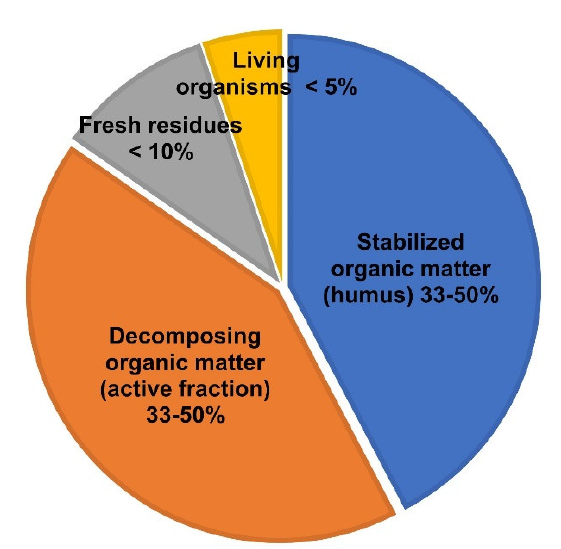
Figure 1. Soil organic matter is carbon-based substances in soil, including leaves, roots and living organisms such as earthworms [17].